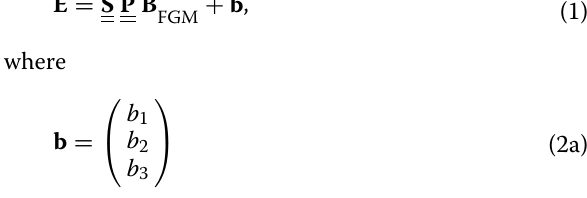
1 3 ) on the CryoSat‑2 satellite (Credit: ESA/AOES = −